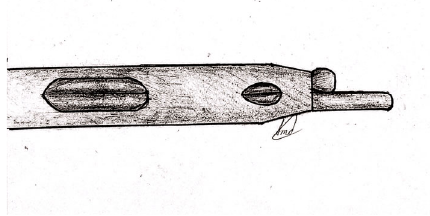
Figure 4. The interference fit–guide wire method.